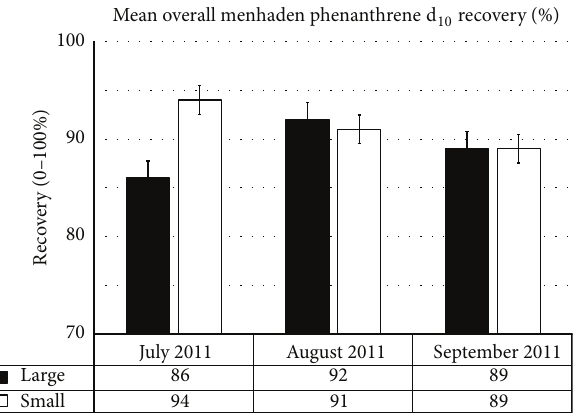
Figure 4: Overall mean phenanthrene d 10 recoveries based on size and month, Summer 2011 (recoveries by month were not significantly different 𝛼 = 0.05